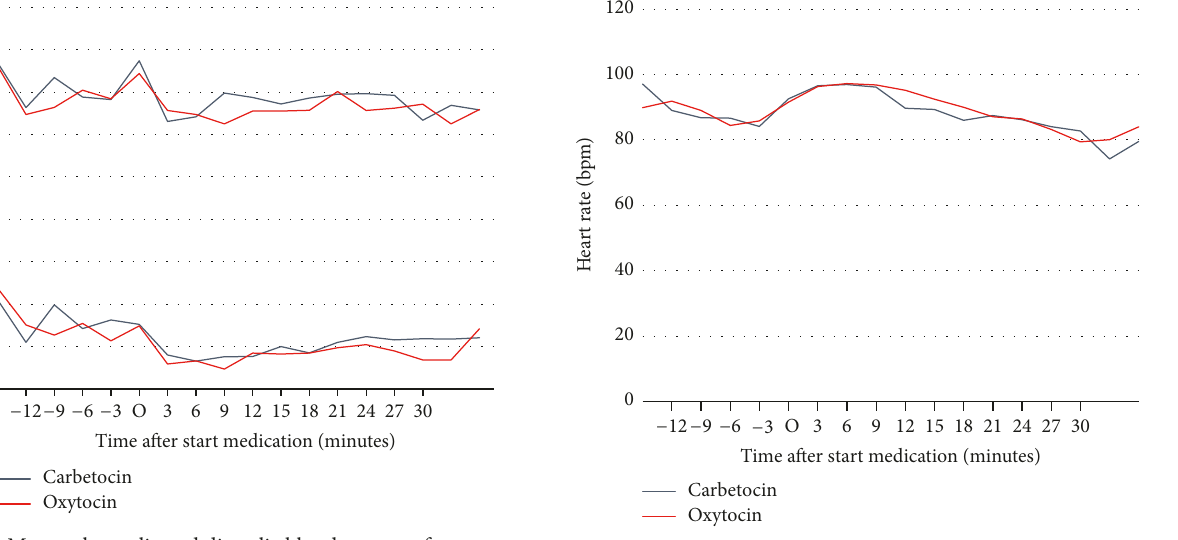
Figure 3: Maternal heart rate from start anaesthesia until the end of the procedure; time point O = start medication; data are displayed as